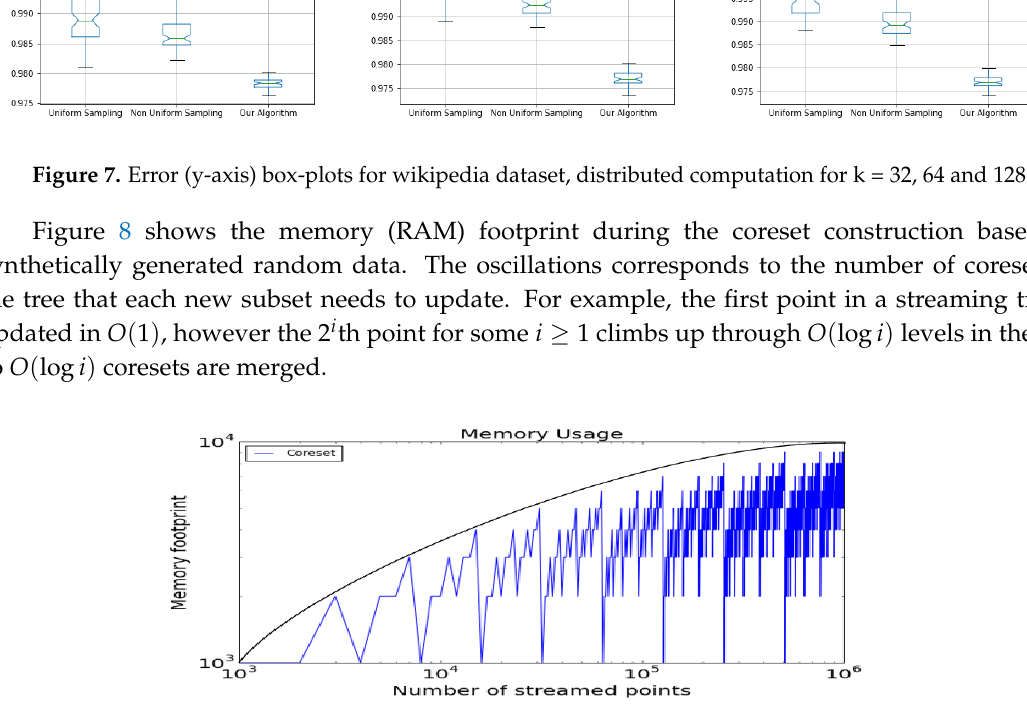
Figure 8. Allocated memory (y-axis) grows logarithmically during streaming coreset construction. The Zig-zag patterns caused by the binary merge-reduce tree in Figure